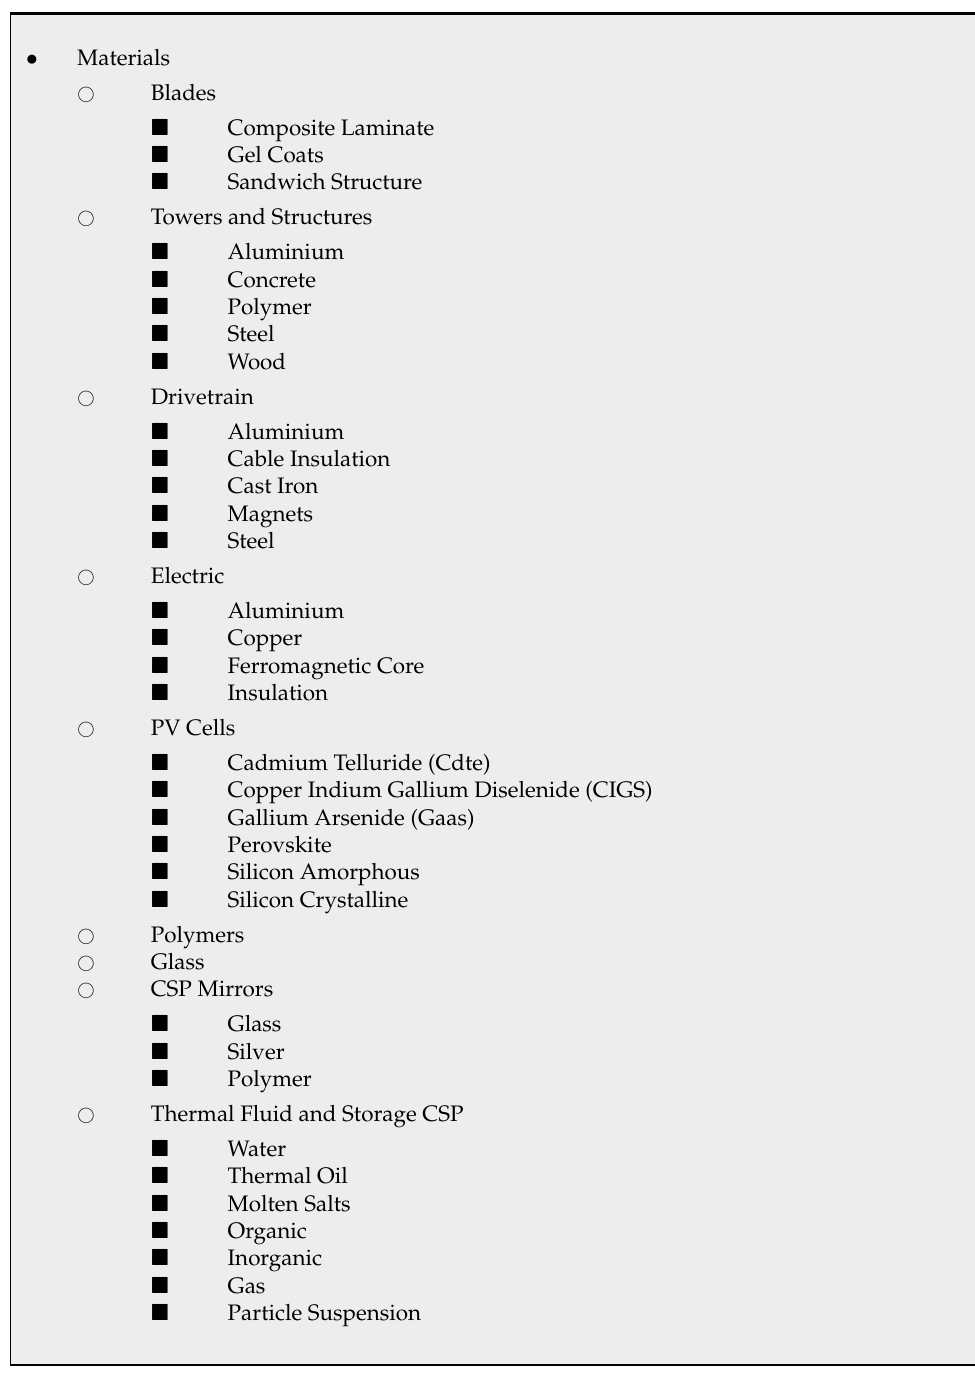
Table 20. Hierarchy for Material-related